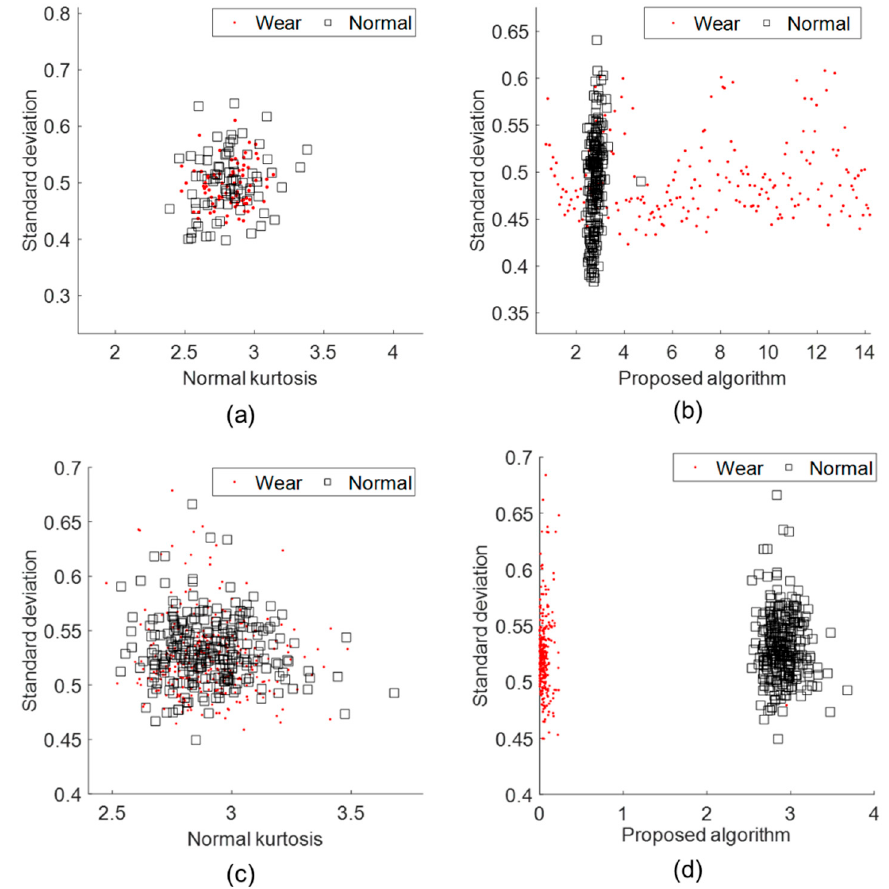
Figure 8. Data Distribution: ( a ) feature variables on AI7075; ( b ) feature variables with proposed algorithm on AI7075; ( c ) feature variables on SM45C; ( d ) feature variables with proposed algorithm on SM45C.